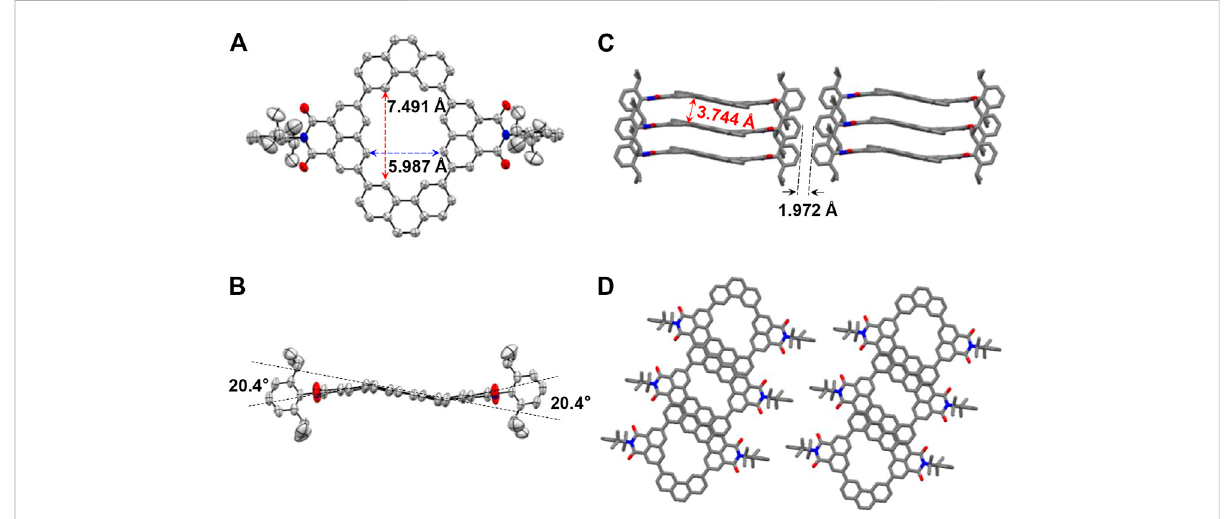
FIGURE 2 X-ray crystallographic structures of NP2a. (A) Top view and (B) side view of the molecule. (C,D) 3D packing structures of